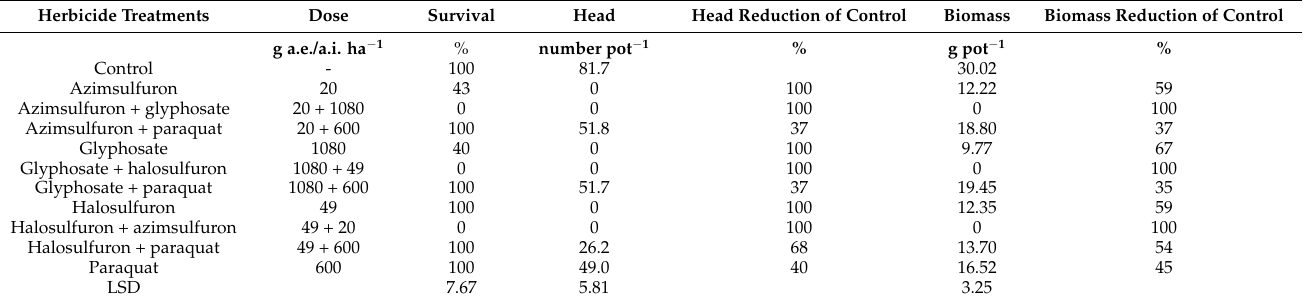
Table 6. The effect of herbicide treatments on the survival, seed head number, and biomass of Navua sedge when sprayed on 40–42 cm tall plants (140–150 leaf